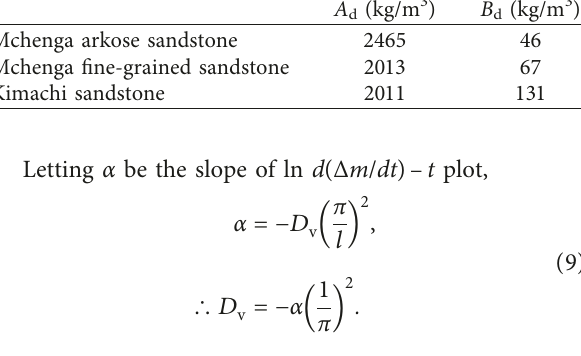
Figure 12: Bulk density variation against humidity. (a) Mchenga arkose sandstone. (b) Mchenga fine-grained sandstone. (c) Kimachi sandstone. Table 1: Coefficients to represent density as a function of relative humidity. A d (kg/m 3 ) B d (kg/m 3